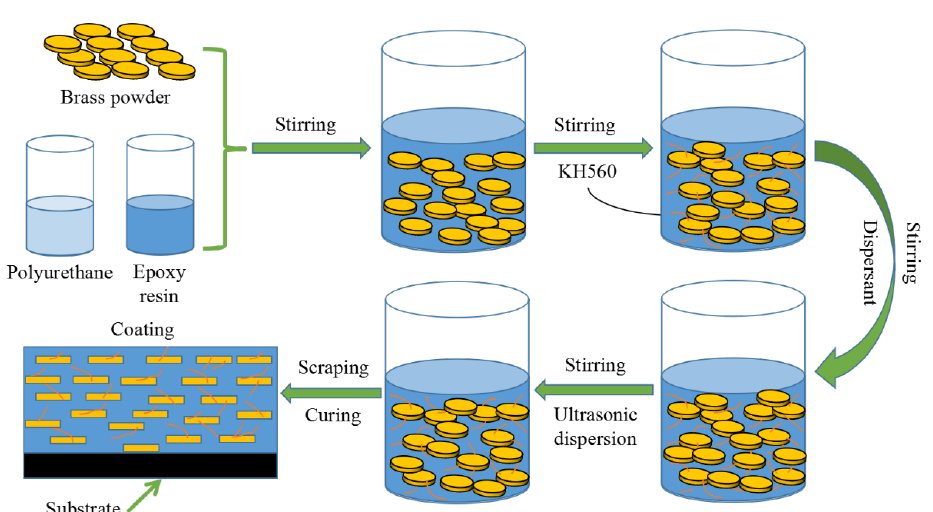
Figure 1. Preparation process of the coating.